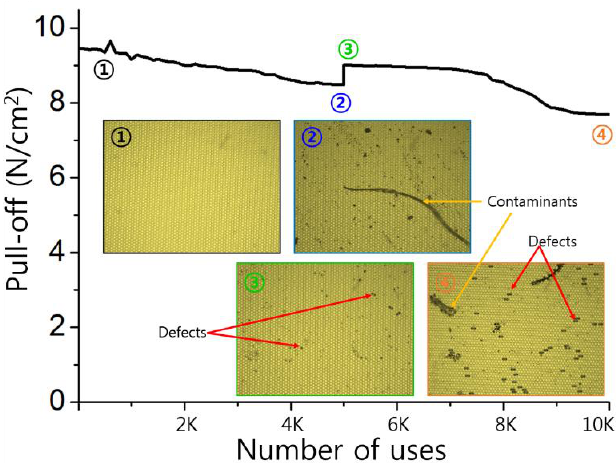
Figure 4. Durability test of the fabricated dry adhesives over 10,000 cycles of attachment and detachment. Inset microscopic images for dry adhesive surfaces at initial state, 5000 cycles before cleaning, 5000 cycles after cleaning, and 10,000 times usage.